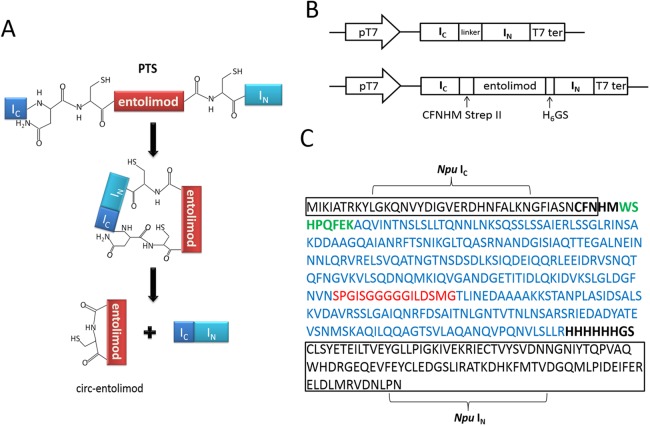
Entolimod cyclization in vivo using trans-splicing activity of Npu DnaE intein.(A) The two fragments of intein, IN and IC, interact to form an active intein that splices to cyclize entolimod placed in between. Splicing mediates the ligation of the N and C termini of entolimod through a native peptide bond. (B) Schematic representation of expression plasmids pET/Ssp DnaE-28a(+) or pET/Npu DnaE-28a(+) and pET/Ssp DnaE/entolimod-28a(+) or pET/Npu DnaE/entolimod-28a(+). (C) The fusion protein sequence of Npu IC—entolimod—Npu IN. The C-terminal 39-residue segment and the N-terminal 102-residue segment of the Npu DnaE intein are enclosed within rectangles. The linker sequence of CFNHMWSHPQFEK (StrepII-tag, green type) and H6 (H6-tag) GS is shown in bold font. The amino acid sequence of entolimod is shown in blue type, the sequence (red type) between N- and C-terminal encodes a flexible linker domain which is replaced by a hyper-variable domain of flagellin.